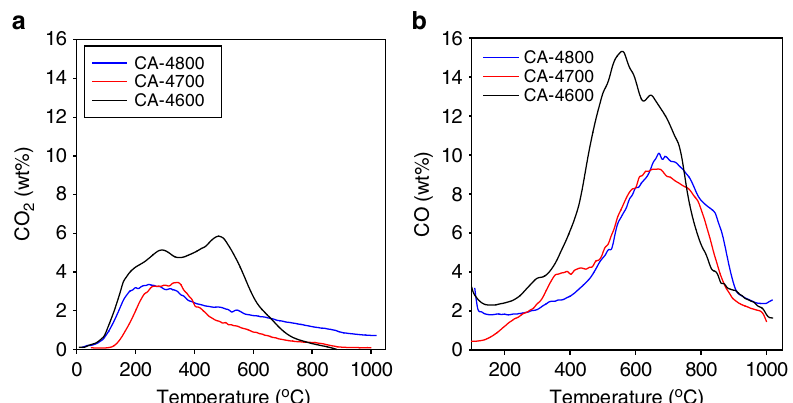
Fig. 5 Temperature-programmed desorption of activated carbons. Evolution of a CO 2 and b CO under temperature-programmed desorption (TPD) conditions for activated carbons derived from cellulose acetate. The activated carbons are labelled as CA-4T, where 4 is the activation KOH/carbon ratio and T is the activation temperature in °C